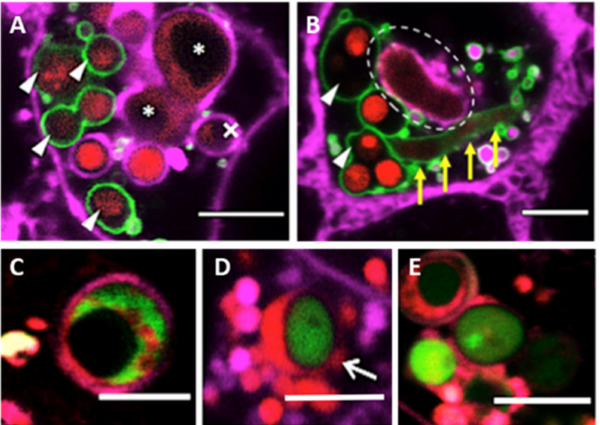
Figure 4. Killing of A. fumigatus within A549 alveolar epithelial cell lines. ( A ) Single airway epithelial cell containing digested (triangles) and killed germlings (asterisks) within phagolysosomes. The cross symbol refers to the crescent feature after digestion of a spore within a phagosome. ( B ) Hyphal killing occurs within phagolysosomes (yellow arrows) and within phagosomes (indicated by dashed circle). ( C ) Killing of A. fumigatus within the acidified phagosome. ( D ) Residence of A. fumigatus spore co-localized within acidic niche for more than 18 h. ( E ) Spore swelling within the acidified phagosome 24 h of inoculation. Color code for panels A and B: Magenta = epithelial cells membrane (CellMask Deep Red), Green = lysosomes (GFP-LAMP1), red = A. fumigatus (MFIGRag29). Color code for panels C–E : Magenta = epithelial cells membrane (CellMask Deep Red), Red = Acidic organelles (RFP-Lysotracker), Green = A. fumigatus (MFIGGFP4, Table S1). Scale Bar = 5 µ